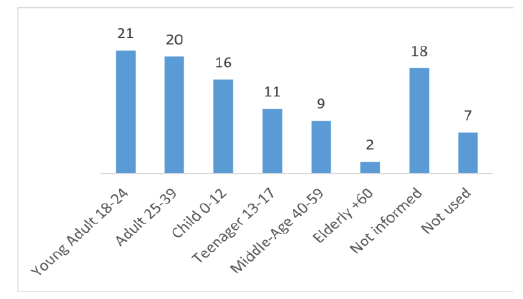
Figure 4. Evaluated Age